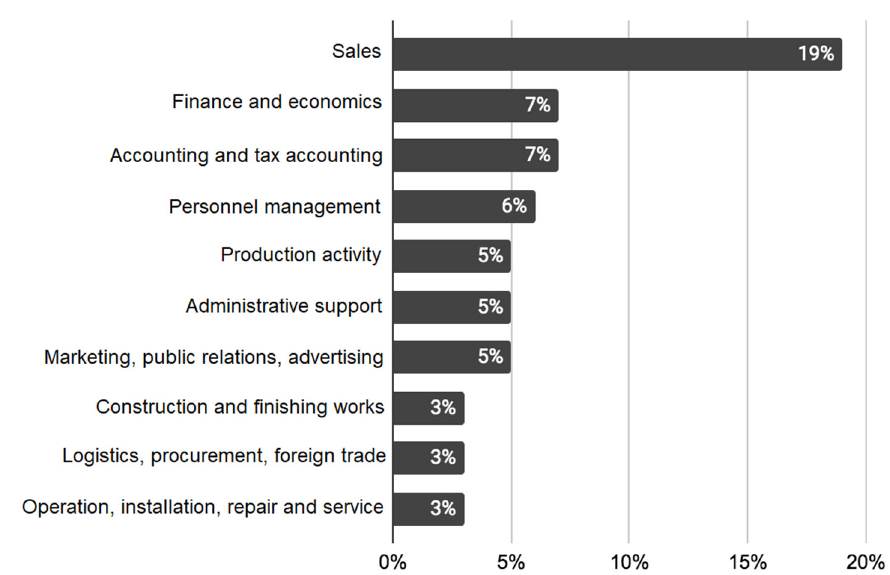
Figure 2. Share of applicants who would like to change jobs, subject to the same high salary, in various professional fields (Compiled by the authors based on materials of Almanac HeadHunter (2017)).